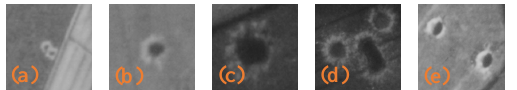
Figure 1: Bomb craters appear differently in aerial images due to varying scales and sizes (a-c) or different appearance (d,